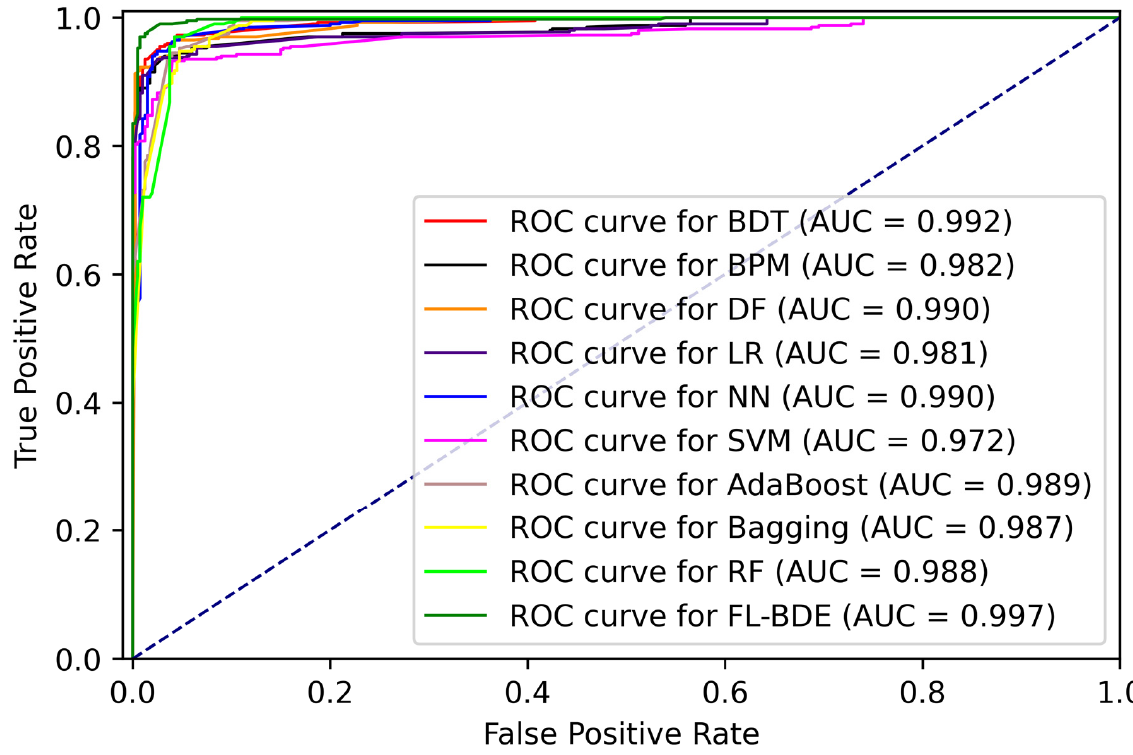
Figure 5. ROC curves of FL-BDE, ML- and EL-based models at the split ratio of 0.60.